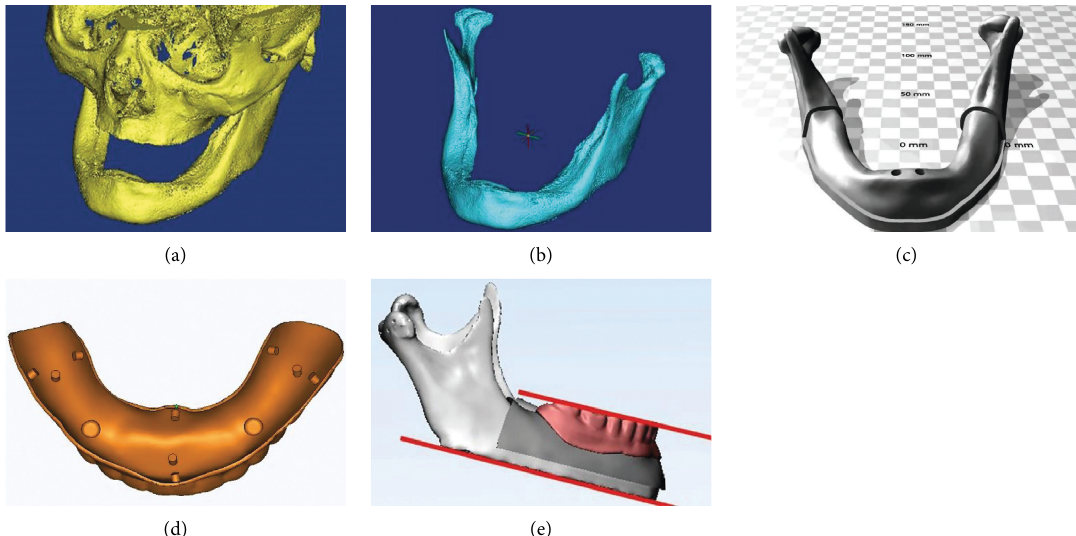
Figure 1: 3D modeling of mandible and denture. (a) DICOM file of the skull and mandible. (b) Mandible extracted from the skull. (c) Representative 3D mandibular model of the 5mm group. (d) Representative 3D denture model of the 20mm group. (e) Complete overdenture model with base flattened parallel to denture occlusal plane.